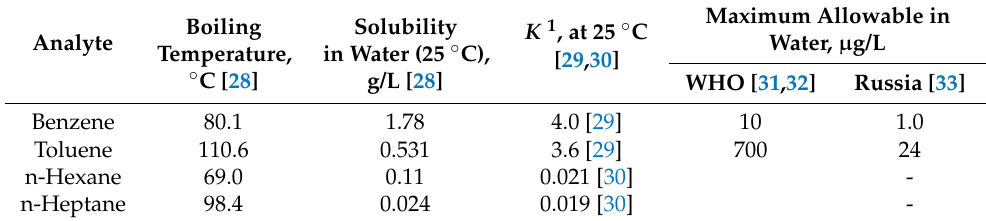
Table 1. Characteristics of